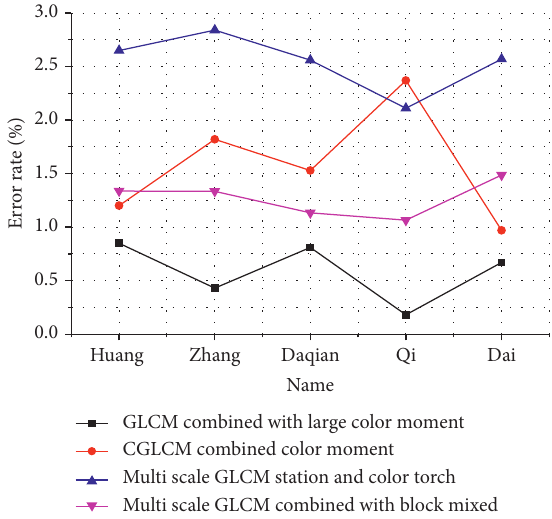
Figure 8: Comparison of the average correct classification rate of integrated vector